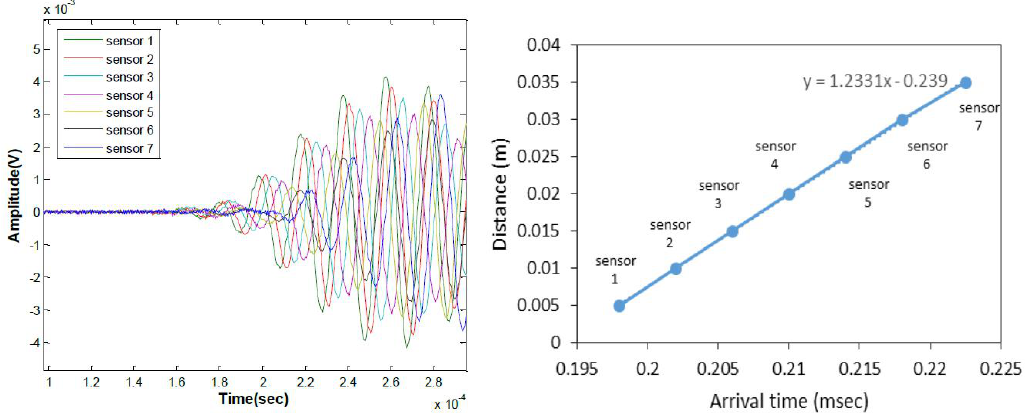
Figure 14. Ultrasonic surface wave signals collected with sensor array along wave path on PMMA; time signals ( left ) and presentation surface wave arrival time ( right ).